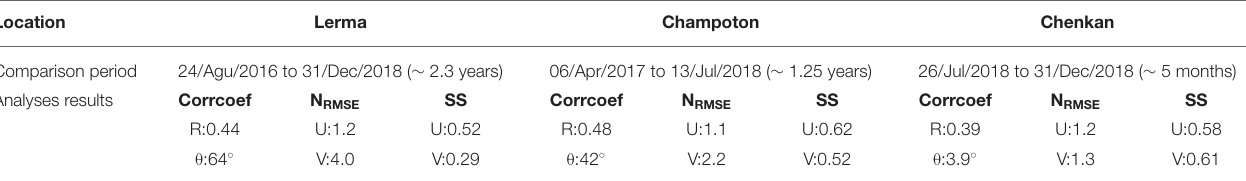
TABLE 3 | Results of the comparative analyses between ADCP currents and modeled observations. Location